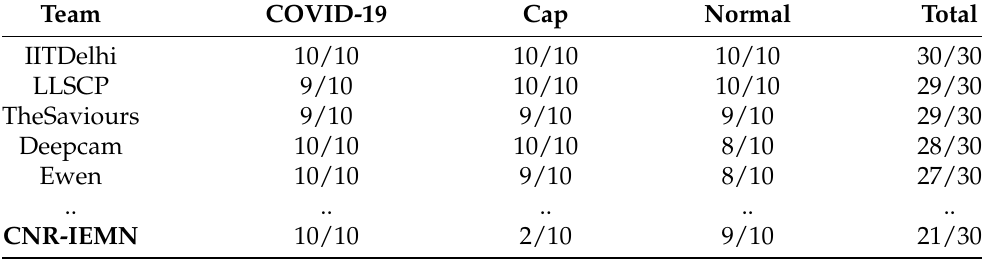
Table 8. Third testing split results.